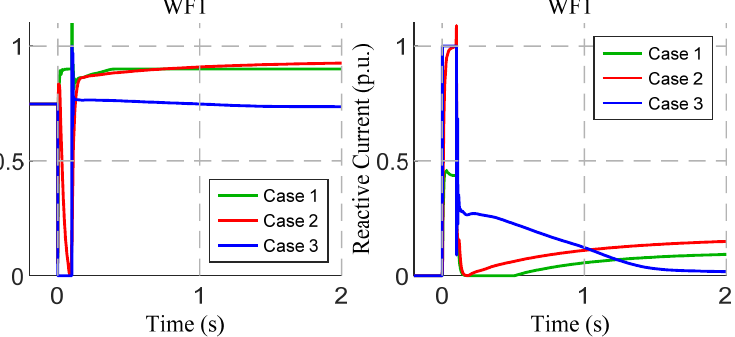
Figure 18. WF1 active and reactive current outputs following different reactive current-voltage injection profiles.